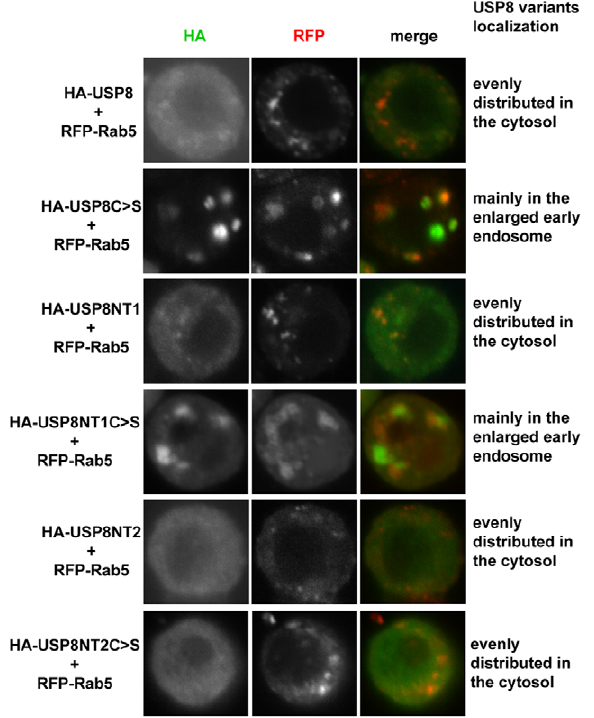
Figure 9. The localization of USP8 variants in S2 cells. S2 cells were cotransfected with USP8 constructs and RFP-Rab5 followed by immunostaining with an anti-HA antibody to label the expression of USP8 constructs. Rab5 marks the early endosome. Of note, the expression of USP8C . S and USP8NT1C . S causes enlarged early endosomes, and both forms of USP8 localize in these enlarged early endosomes. USP8, USP8NT1, USP8NT2, and USP8NT2C . S are evenly distributed in the cytosol without a specific pattern. USP8NT3 behaves like USP8NT2 and USP8NT3C . S behaves like USP8NT2C . S (unpub- lished data).